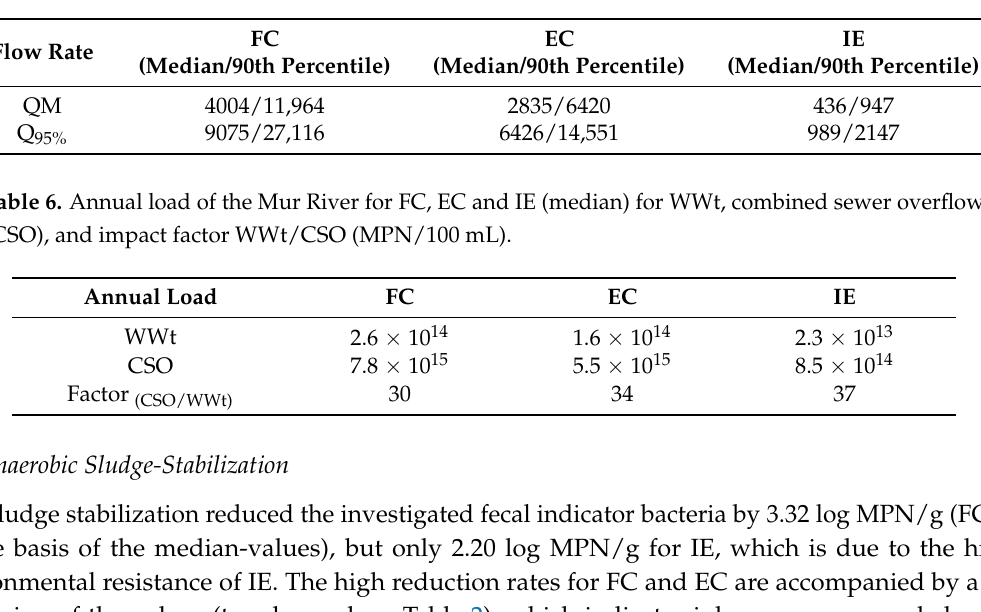
Table 5. Increase of the FIB number (MPN/100 mL) caused by the direct discharge of untreated